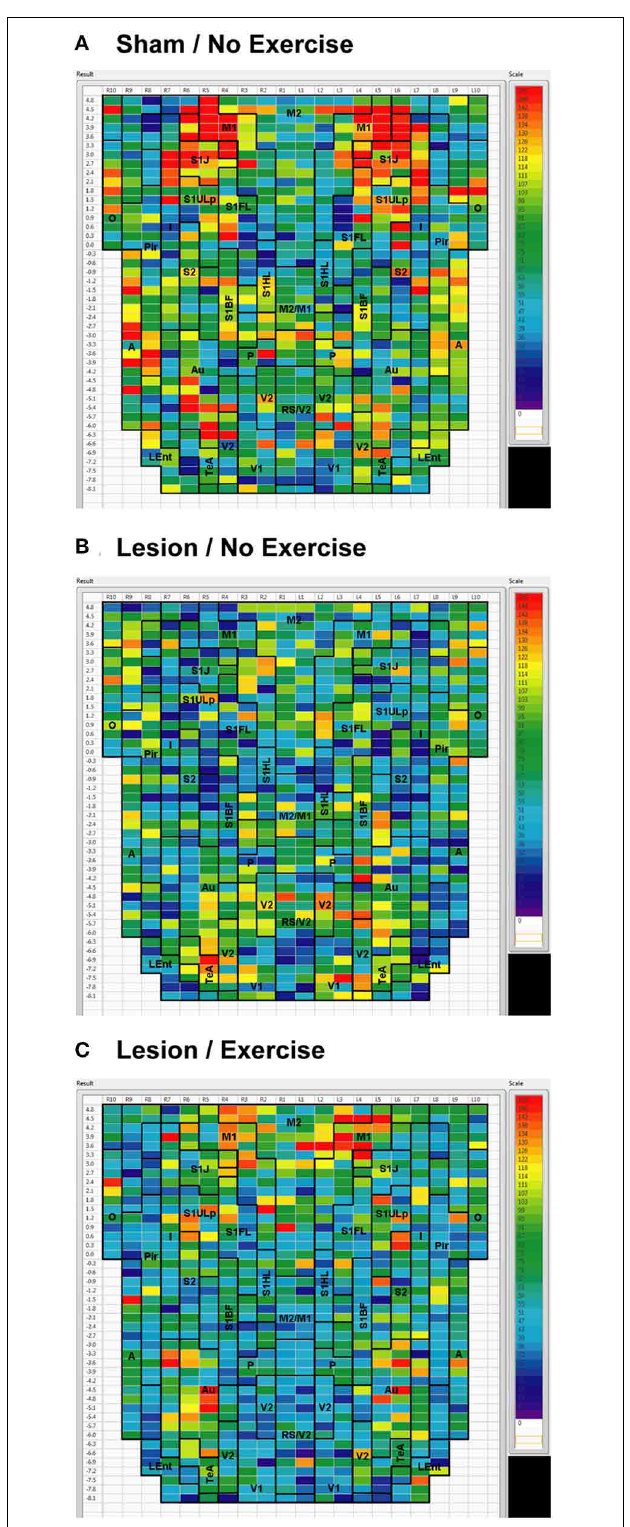
FIGURE 2 | Degree of cortico-cortical functional connectivity. Cortico-cortical functional connectivity degrees in animals